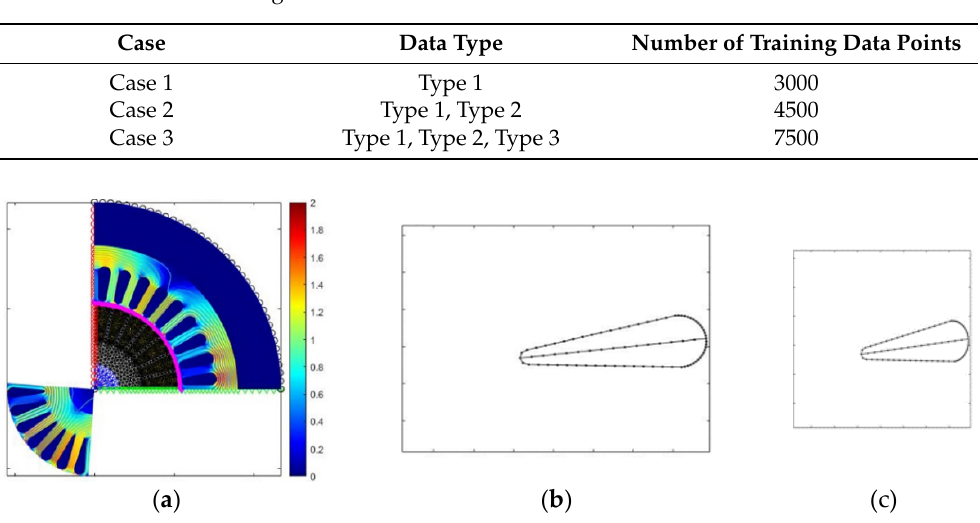
Table 3. Cases of the training data.